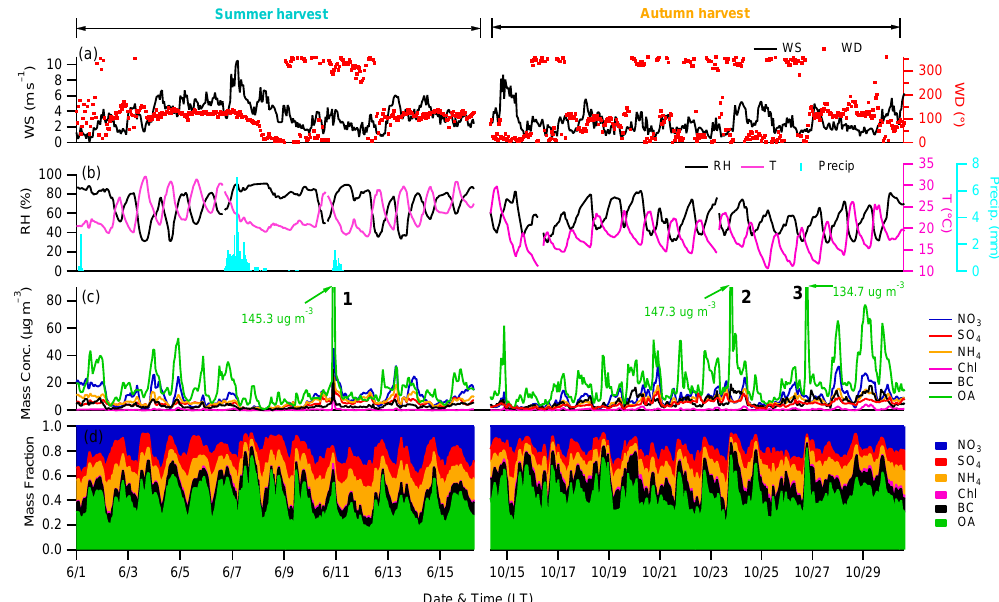
Figure 1. Time series of (a) wind speed (WS) and wind direction (WD); (b) relative humidity (RH), temperature ( T ) and precipitation (Precip); (c) submicron aerosol species, i.e., organic aerosol (OA), ammonium (NH 4 ) , nitrate (NO 3 ) , sulfate (SO 4 ) , chloride (Chl) and black carbon (BC); and (d) mass fraction during the harvest seasons. Three case events are marked and discussed in the